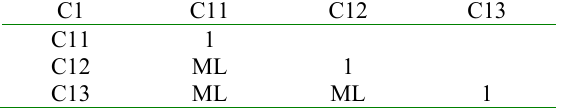
Table 6. Linguistic evaluation matrix of DM2 for C1 sub-criteria